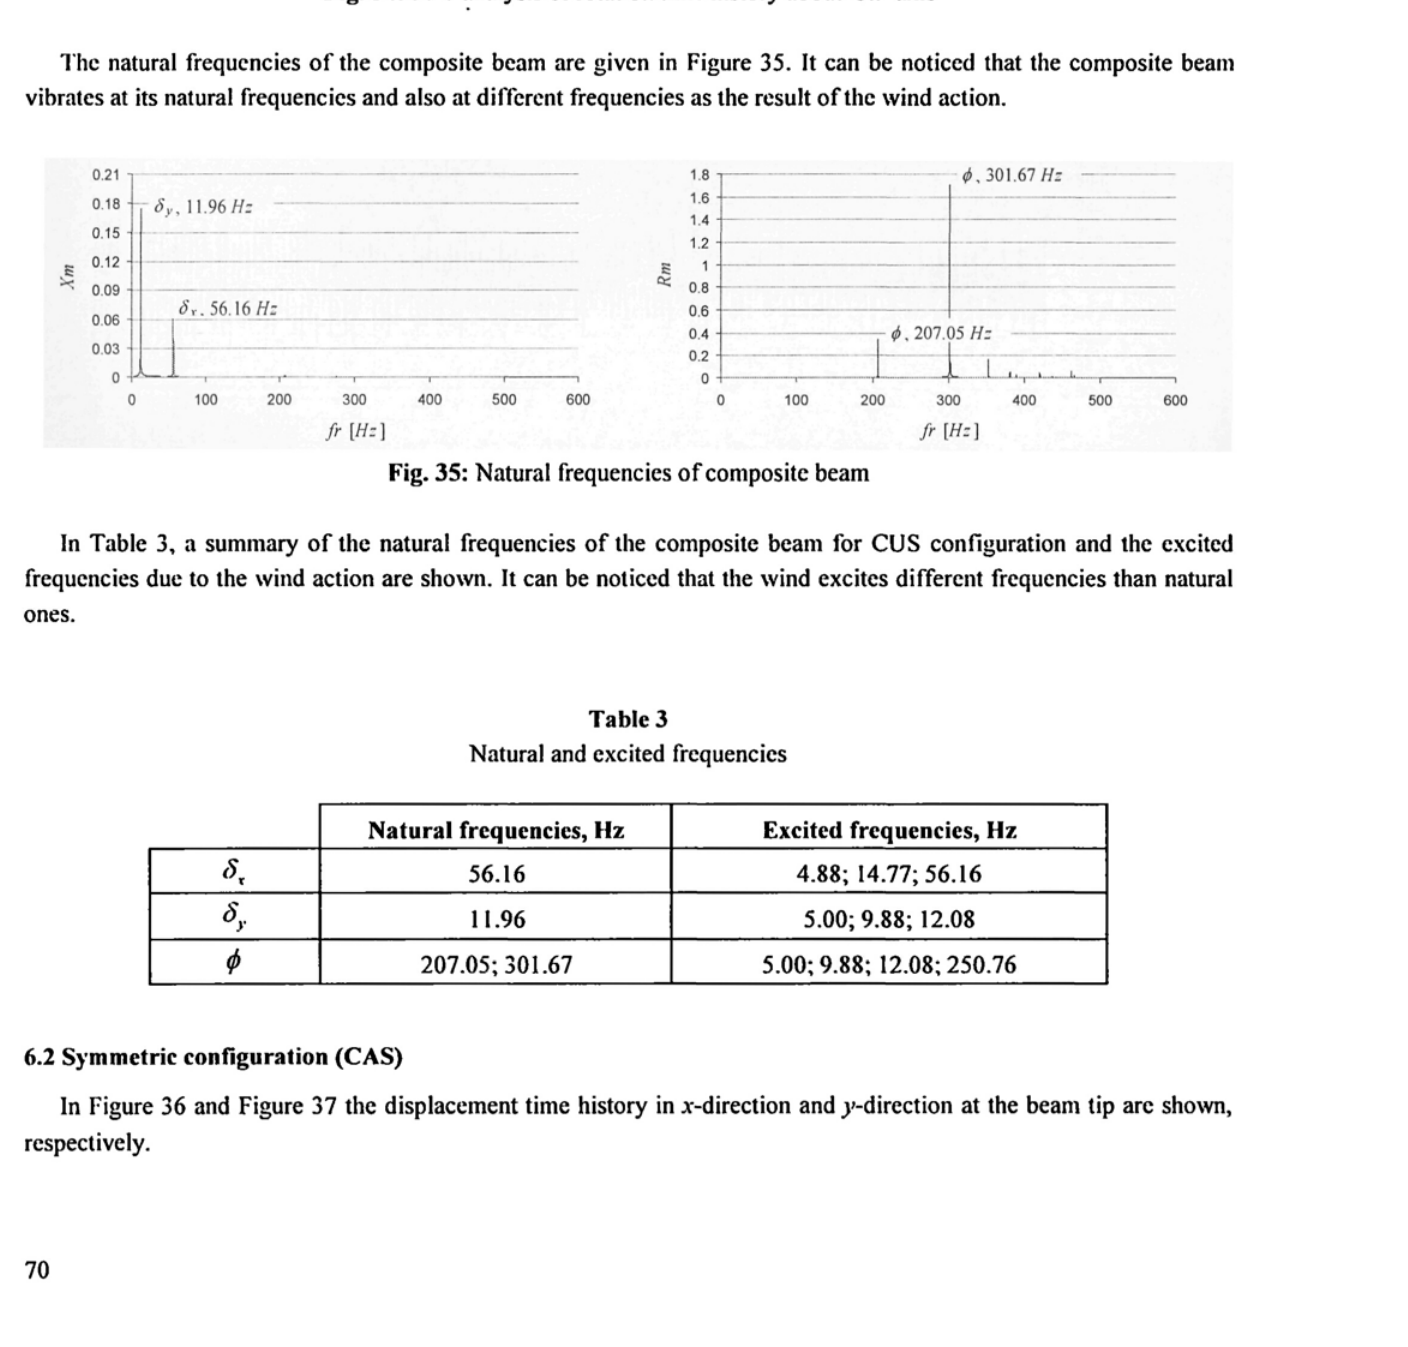
Fig. 34: FFT analysis of rotation time history about Ox axis